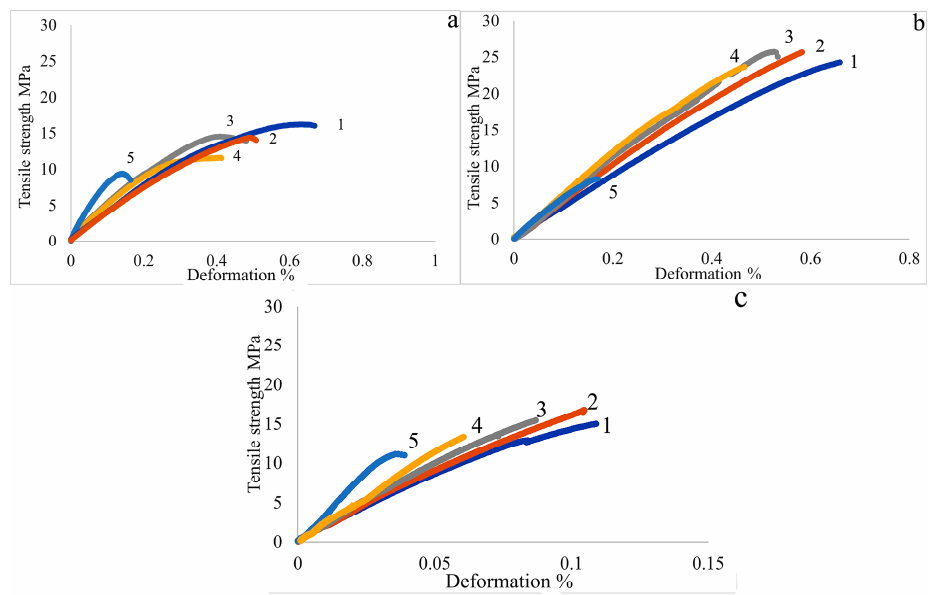
Figure 5. Tensile test curves of PSU based composites filled with 30 (1), 40 (2), 50 (3), 60 (4) and 70 (5) wt.% of NG ( a ), AG ( b ) and EG ( c